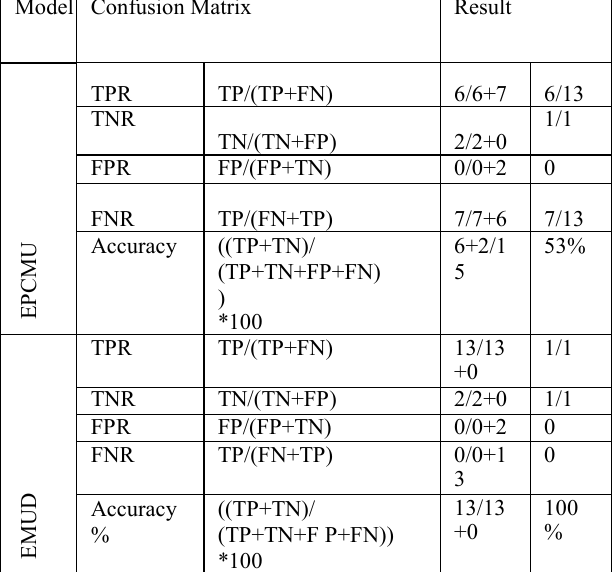
Table 5: Confusion matrix of EMUD and existing model